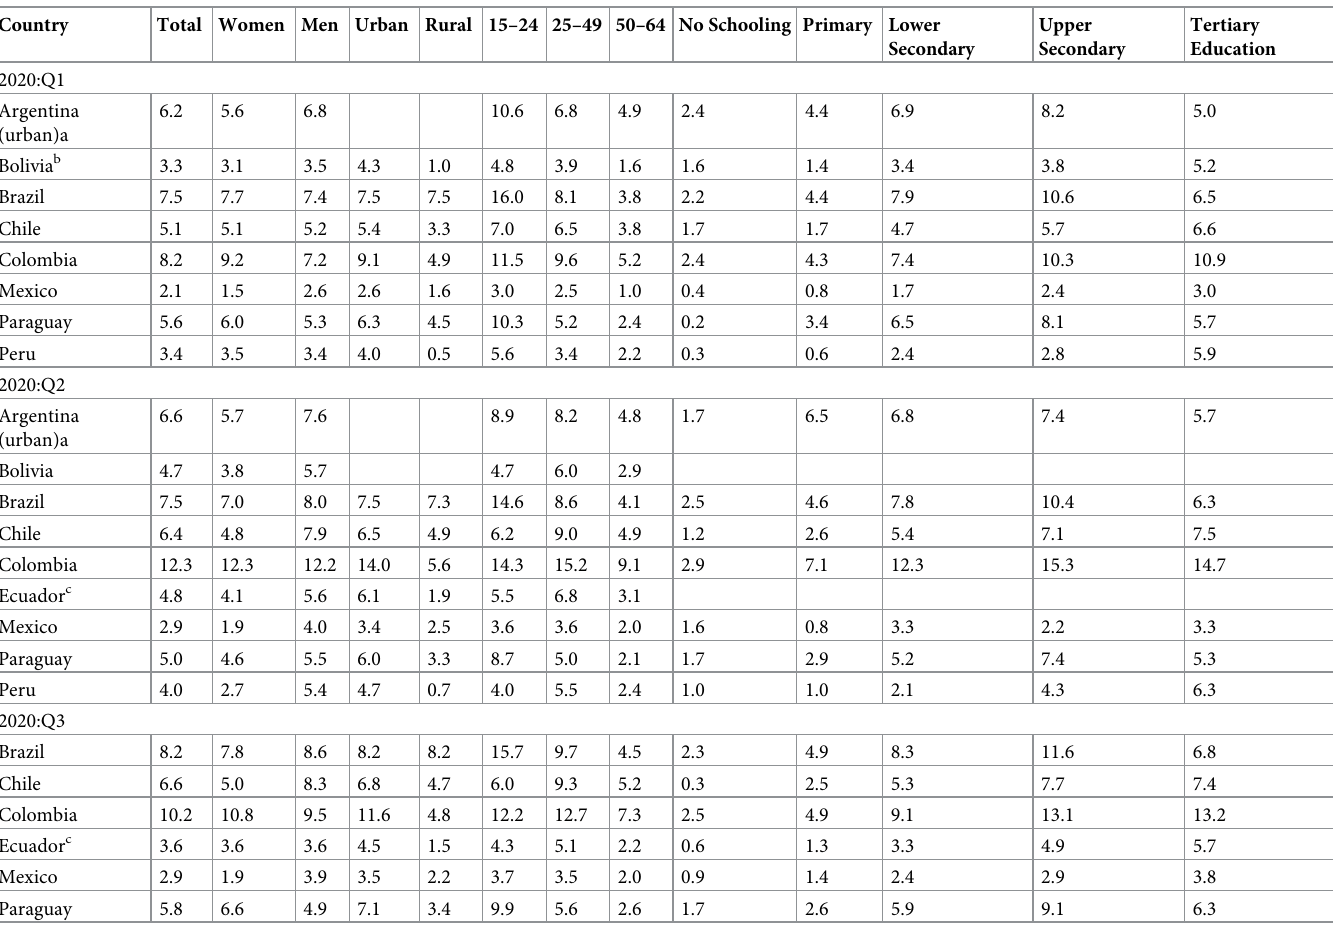
Table 4. Demographic profile of the unemployed population as a percentage of the working-age population, selected Latin American countries, 2020.